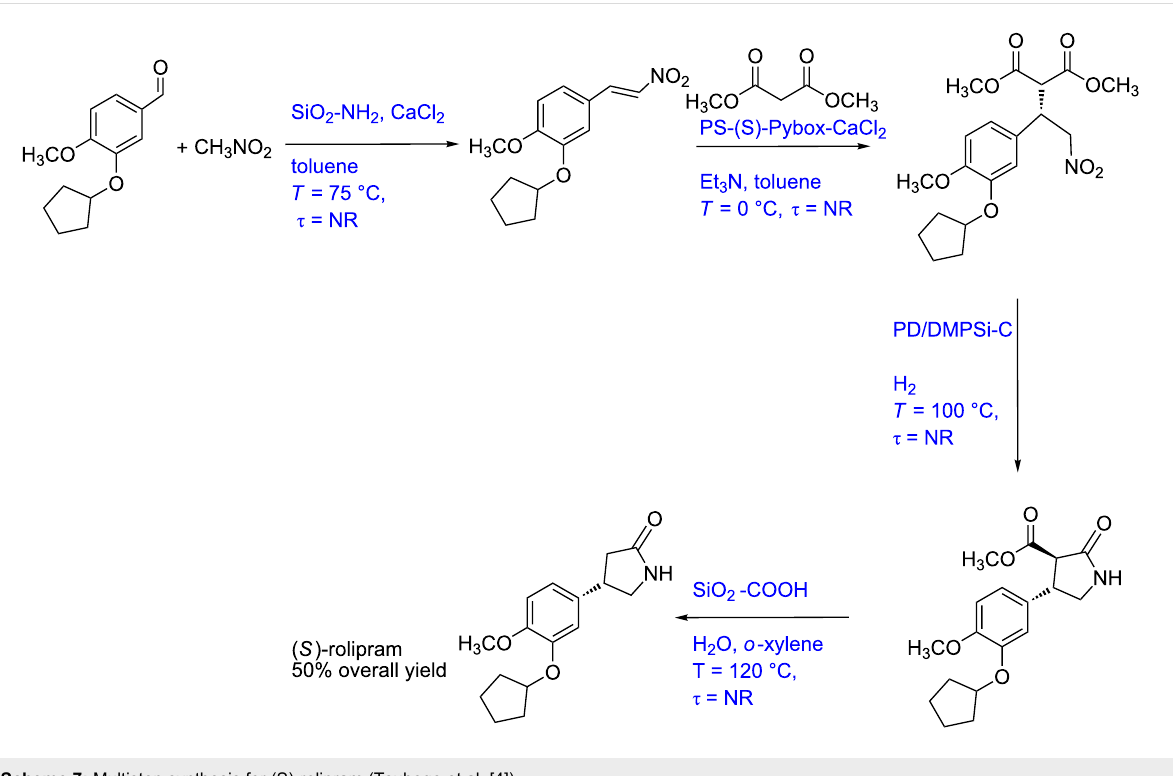
Scheme 7: Multistep synthesis for (S)-rolipram (Tsubogo et al.